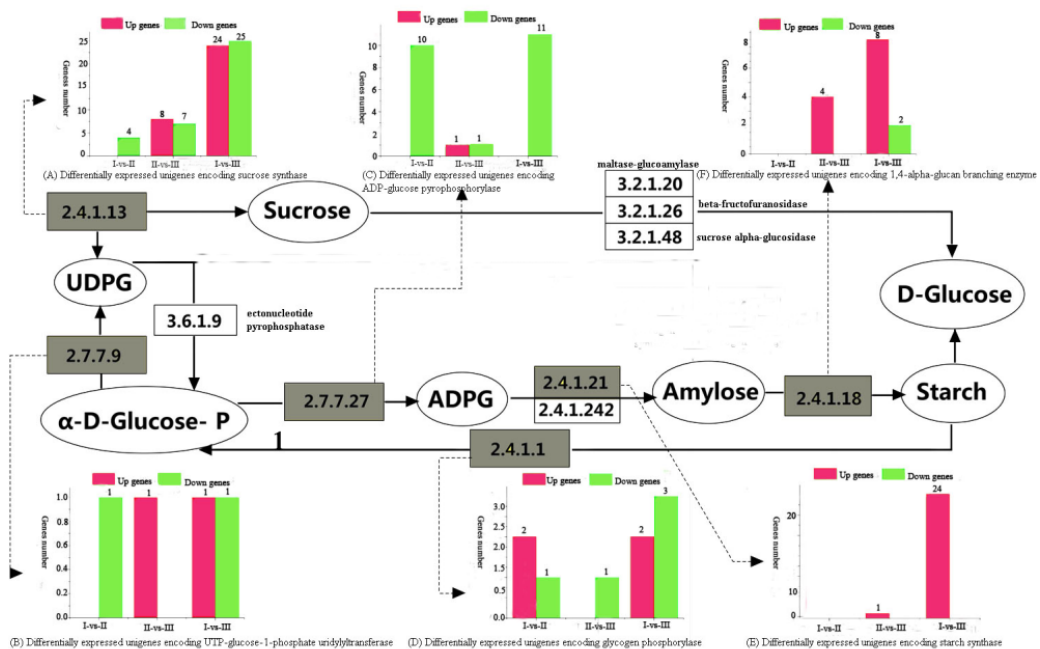
Figure 6. Major KEGG pathways for starch and sucrose metabolism in Chinese chestnut kernel development. Major enzymes with differential gene expression are highlighted. The numbers of upregulated and downregulated genes during the three developmental stages are shown: ( A ) sucrose synthase, ( B ) UTP–glucose-1-phosphate uridylyltransferase, ( C ) ADP–glucose pyrophosphorylase, ( D ) glycogen phosphorylase, ( E ) starch synthase, and ( F ) 1,4-alpha-glucan branching enzyme.